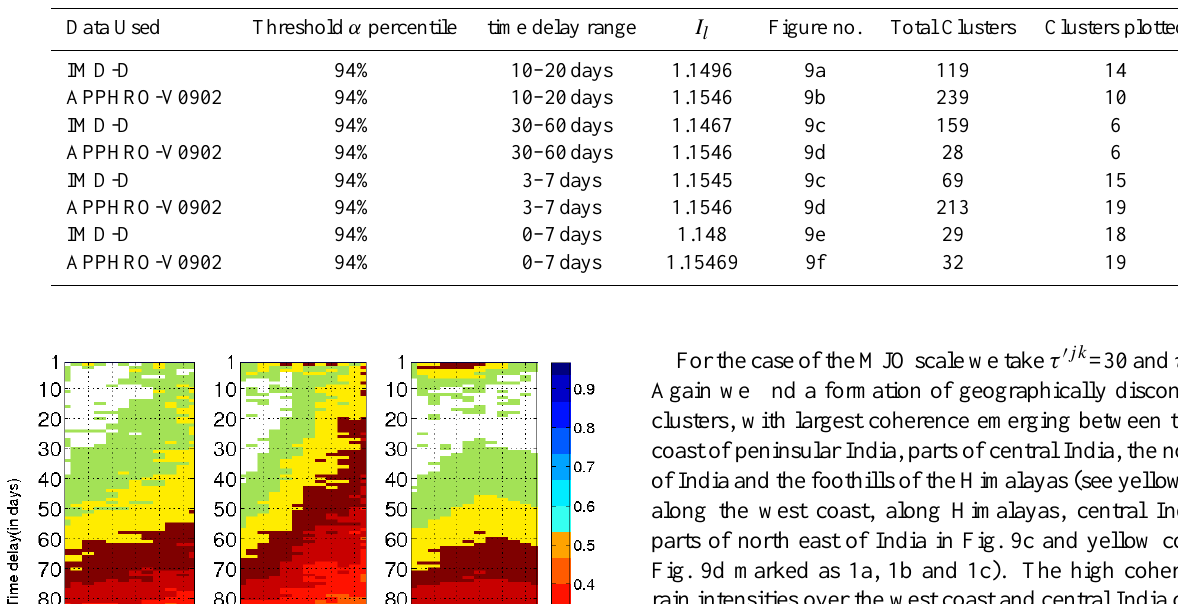
for α = 94% (b) Time delay patterns as obtained form IMD-D for α = 94% (c) Mean wind direction at the height of 850 hPa during rain events above the threshold of α = 94% , derived from NCEP/NCAR data set with time indices for the events calculated from NCEP/NCAR precipitation data